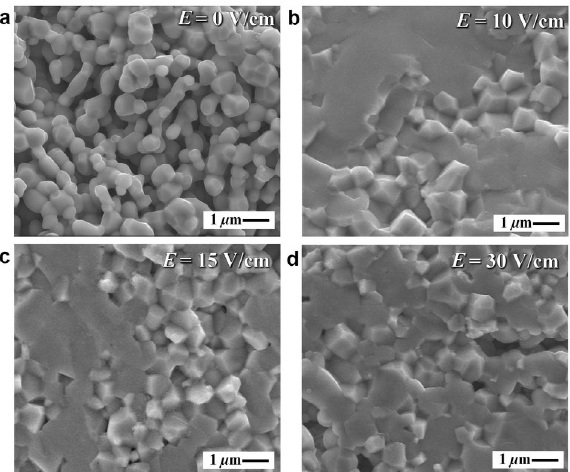
Fig. 5 Representative micrographs of the fracture surfaces (cross section) from CCTO specimens processed in this work. (a) Conventional sintering ( E = 0 V·cm − 1 ); fast O3S processing under (b) E = 10 V·cm − 1 , (c) E = 15 V·cm − 1 , and (d) E = 30 V·cm − 1 , with a current density limit of J = 42.0 mA·mm − 2 and a dwell time of 1